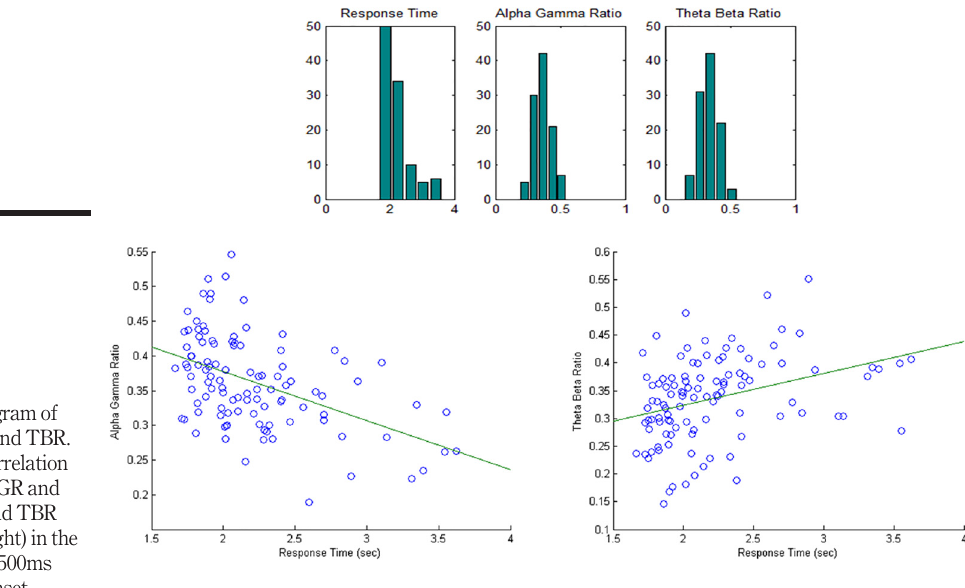
Figure 4. Top: histogram of RT, AGR and TBR. Bottom: correlation between AGR and RT (left) and TBR and RT (right) in the interval of 500ms after cue onset